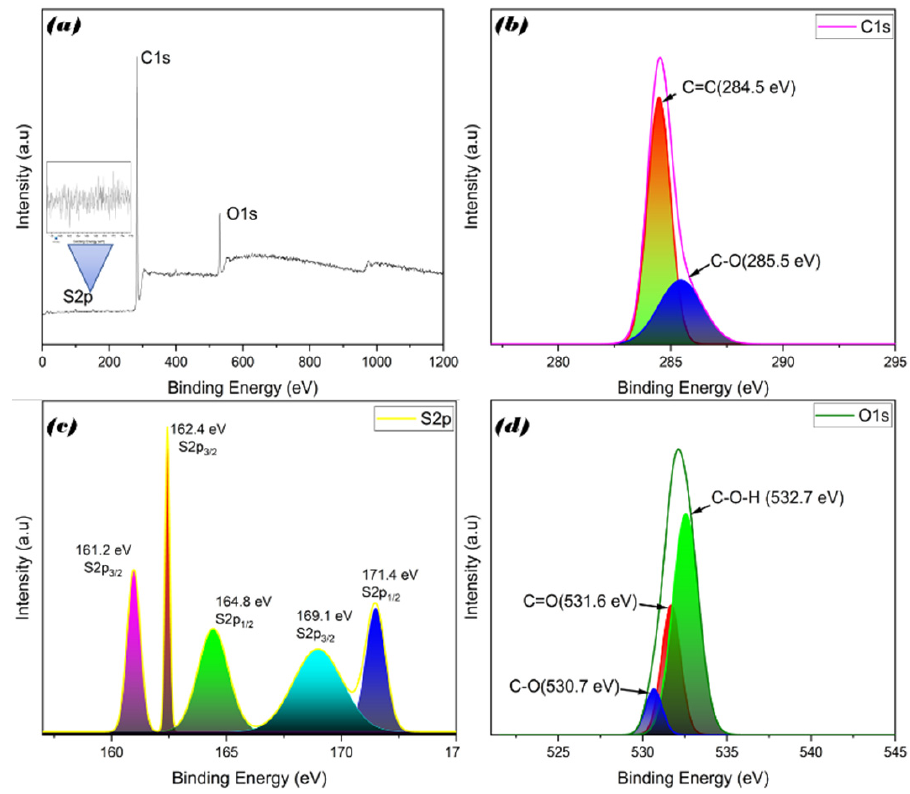
Figure 3. XPS of ( a ) survey spectrum of S-CQDs, ( b ) C1s, ( c ) S2p, and ( d ) O1s peaks.